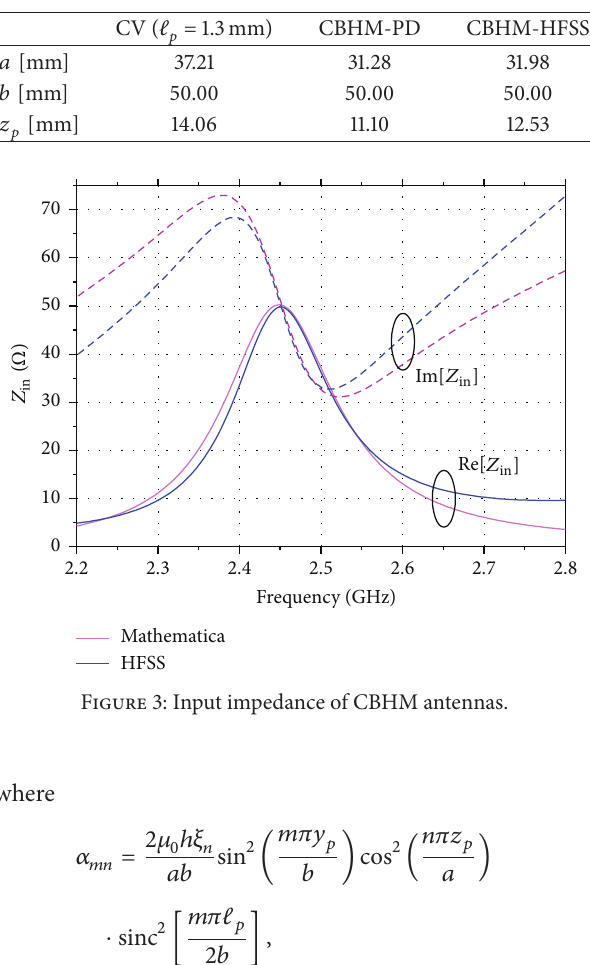
Table 1: CV and CBHM antennas dimensions.